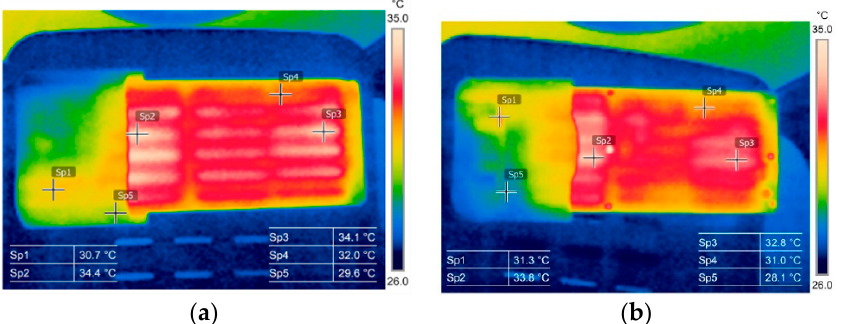
Table 1. Comparison of cameras used for imaging and analysis, FLIR E60bx and E6.